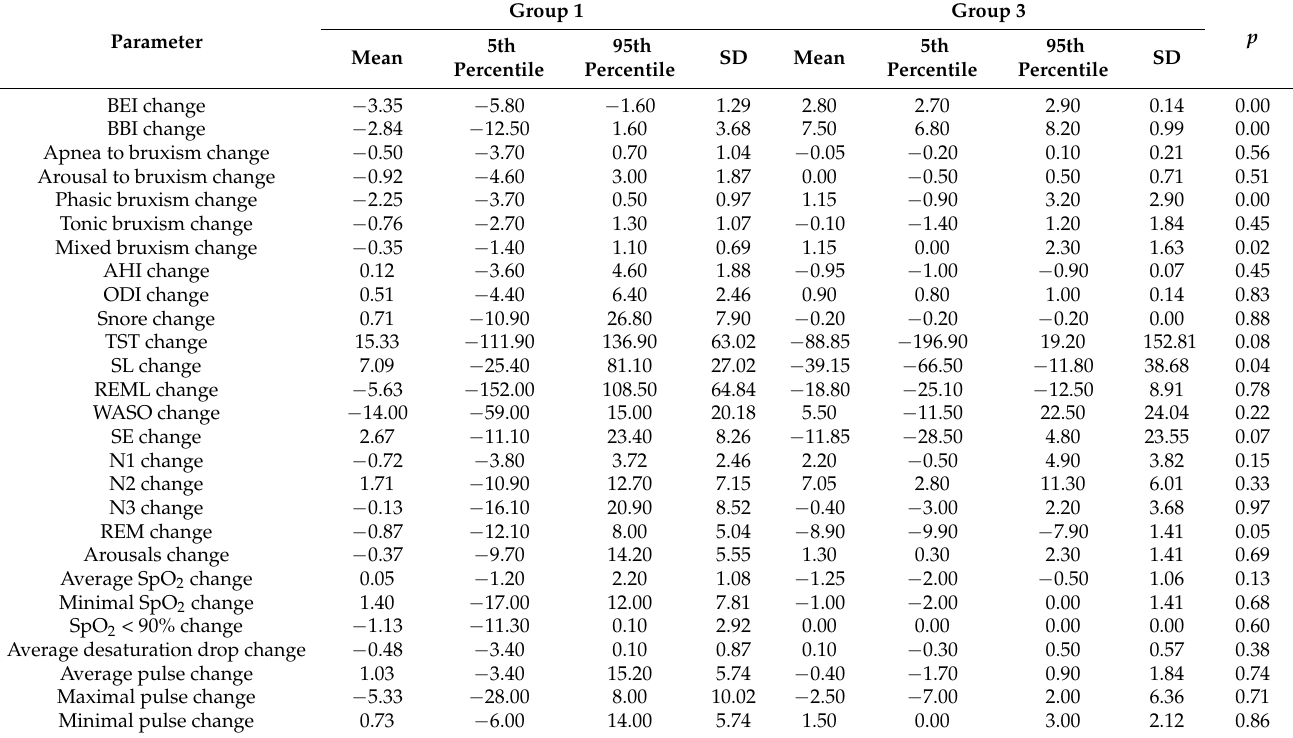
Table 4. Comparison of change in studied parameters between group 1 (SB improvement) and group 3 (SB aggravation).